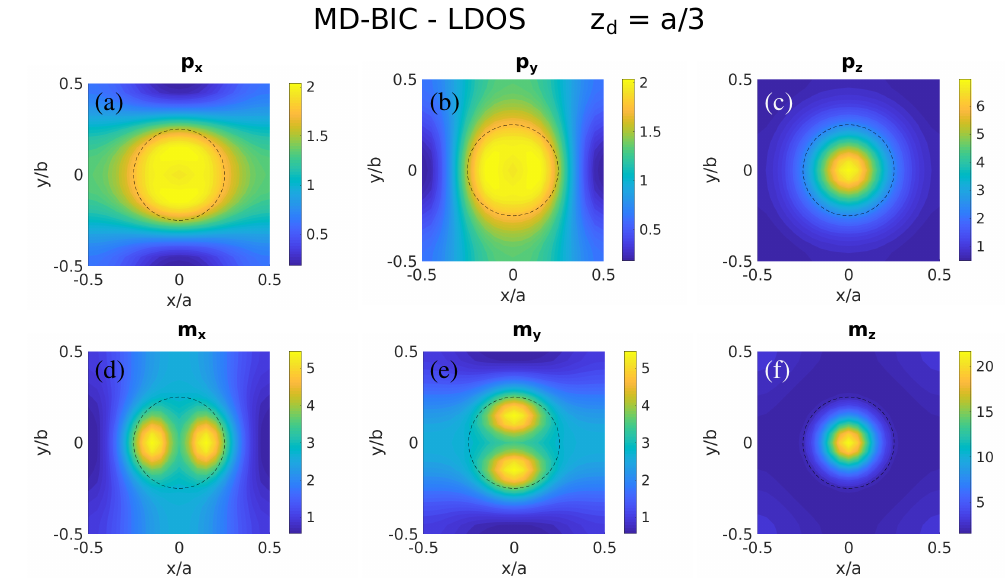
Figure 7. Color maps of the LDOS as in Figure 2, but at the wavelength of the symmetry-protected MD-BIC ( λ = 709 nm and z d = a /3 ≈ 133nm ∼ 0.19 λ ): ( a ) p x , ( b ) p y , ( c ) p z , ( d ) m x , ( e ) m y , ( f ) m z